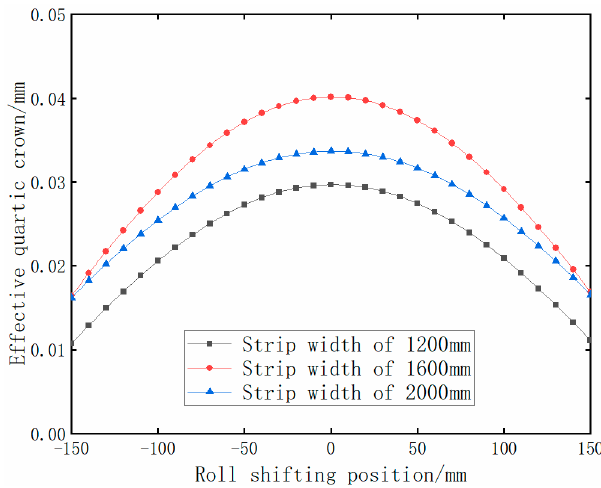
Figure 14. The change in the effective quartic crown of MVCplus with the roll shifting.